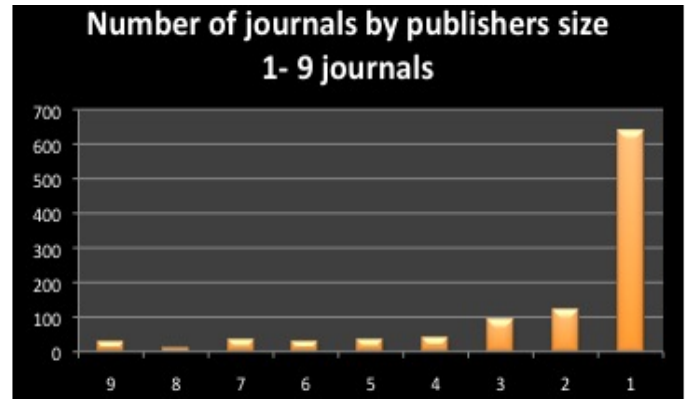
Figure 2. APC journals in DOAJ by publisher size (1–9